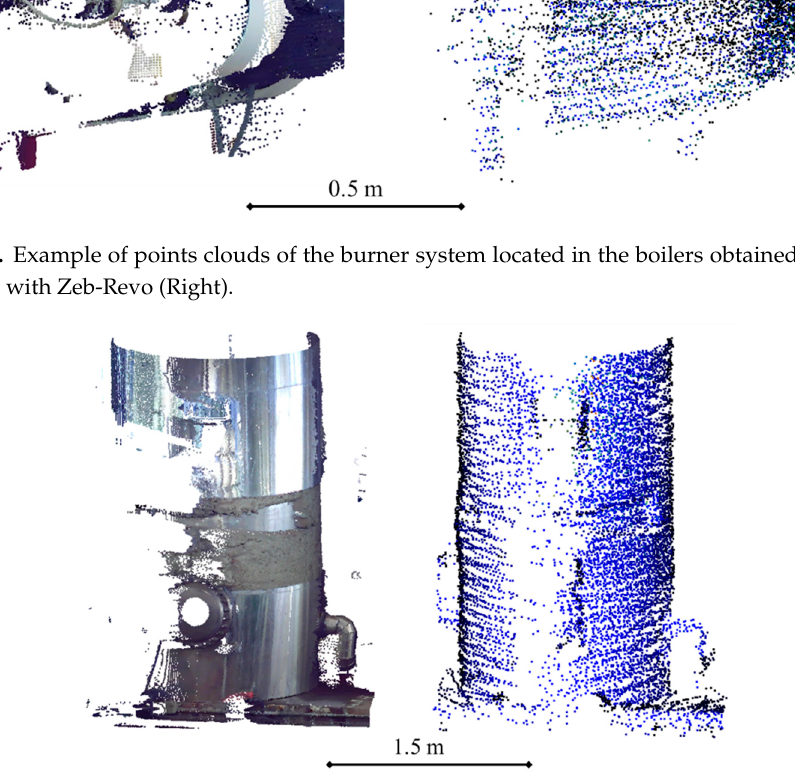
Figure 12. Example of point clouds of the hot water tank obtained with Faro (Left) and with Zeb-Revo (Right).